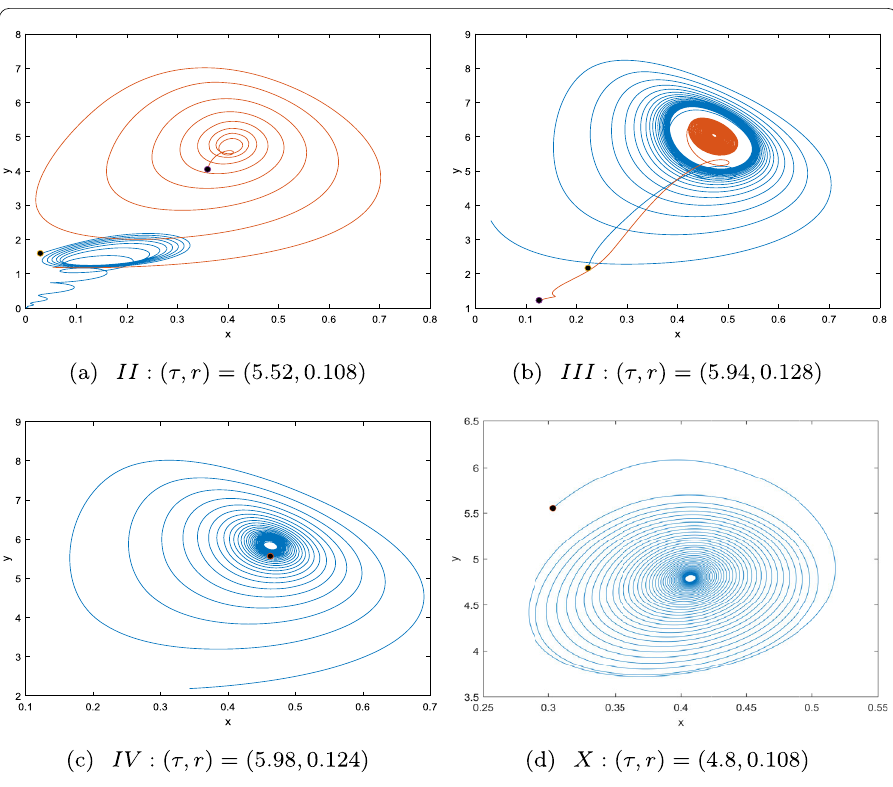
Figure 3 Trajectories of system (1) with different parameters and initializations in regions ( II – IV and X ) of Fig. 1. For convenience, parameter values are given directly at the label of the graph. (a)Two unstable periodic solutions coexist with the initial value (0.2932,1.5887) and (0.3601,4.038), respectively, one of which is stable to the origin. (b)An unstable periodic solution with the initial value (0.2233,2.1588) and an asymptotically stable solution with the initial value (0.1265,1.2177). (c) and (d) have opposite phenomena, one which is asymptotically stable with the initial value (0.3034,5.555), and the other is unstable with the initial value